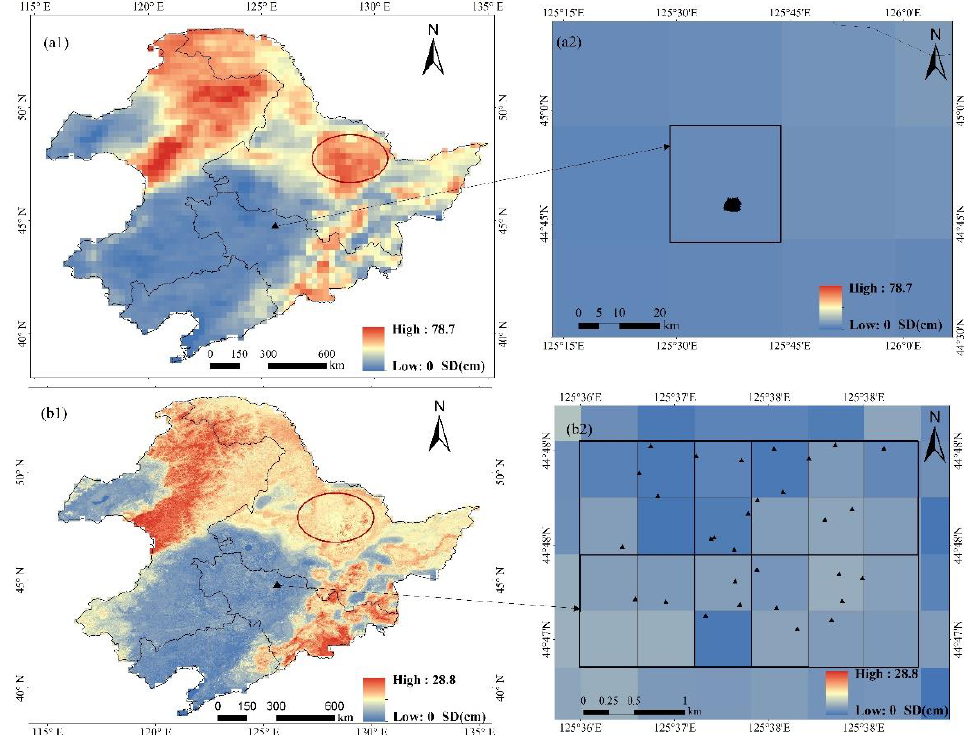
Figure 4. The SD spatial distribution on 23 January 2018 in Northeast China. ( a1 ) AMSR2 (25 km × 25 km); ( b1 ) D AMSR2-product (500 m × 500 m). ( a2 , b2 ) represent the corresponding SD map. The black triangles represent snow observations within the snow quadrat with a spatial resolution of 500 m.